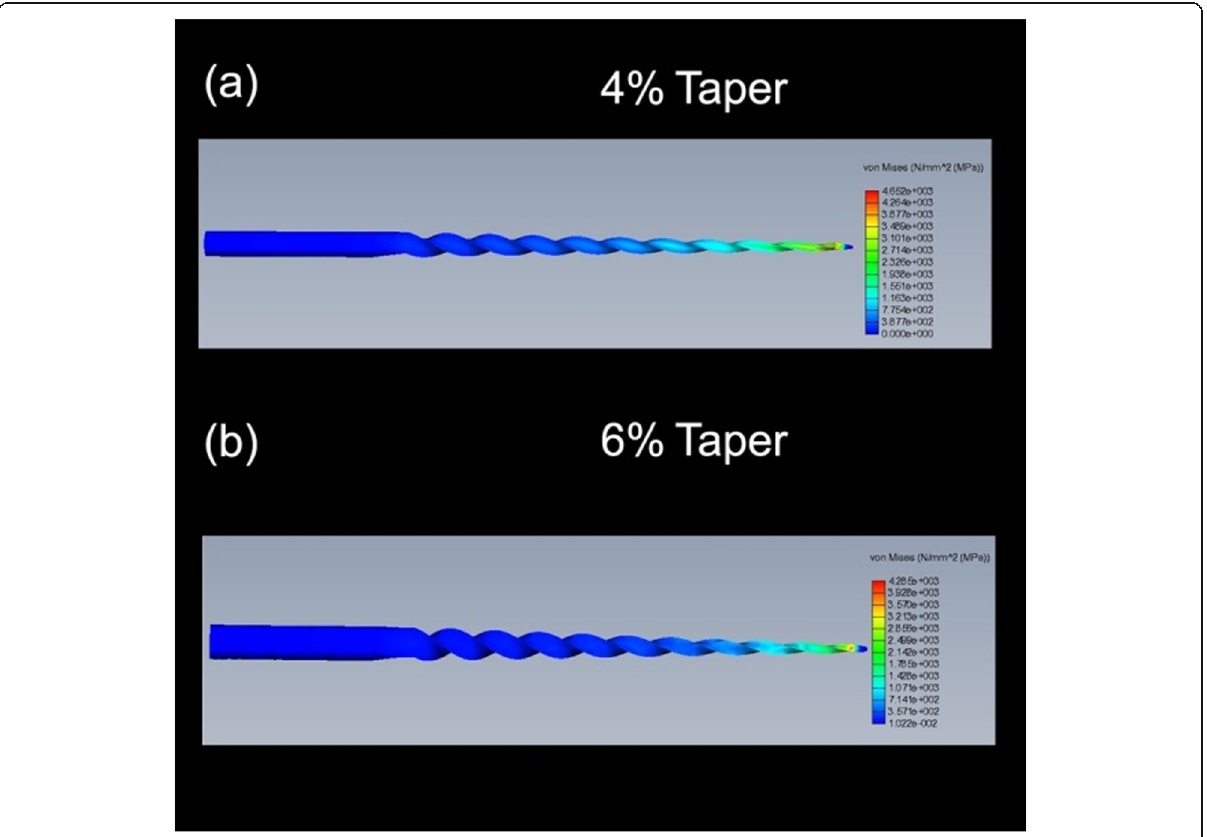
Fig. 8 Stress distribution during torsion of different tested file taper. a 4% taper. b 6%